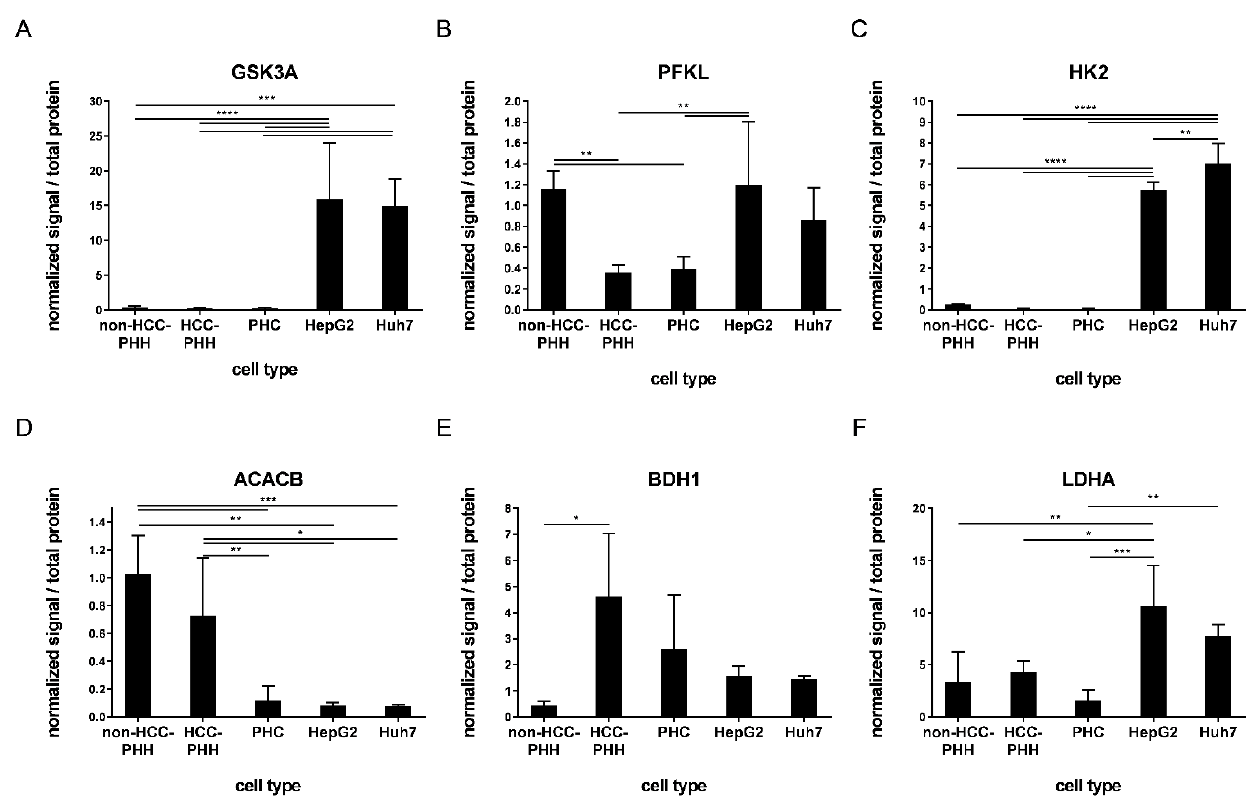
Figure 4. Expression of proteins related to energy metabolism. Cells were cultured for 20 h or snap-frozen directly after isolation, and protein expression levels of central actors in hepatocyte metabolism were determined by Western blot analysis. ( A – F ) PHHs from non-HCC patients (non-HCC-PHH, N = 4), PHHs from HCC-diagnosed patients (N = 5) and PHCs (N = 6) were compared with the hepatoma cell lines HepG2 and Huh7 (N = 3) concerning their expression levels of metabolic proteins. Data are shown as means + SD and were normalized to total protein amount and positive control, n = 1 – 2, one- way ANOVA and post hoc Tukey’s test, * p ≤ 0.0332, ** p ≤ 0.0021, *** p ≤ 0.0002, **** p < 0.0001. Abbreviations: PHH, primary human hepatocyte; PHC, primary human hepatoma